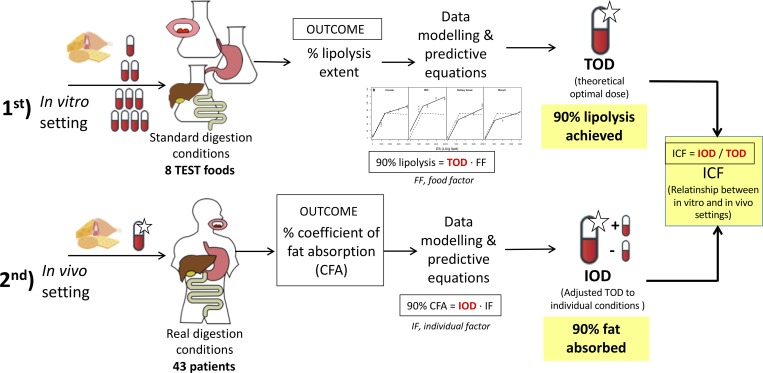
Overview of the combined in vitro and in vivo approach to validate a new evidence-based predictive model to optimally adjust the dose of enzymatic supplements used in PERT, adapted to food and patient characteristics.First a selection of 8 meals were digested in vitro under standard CF conditions, and the % of lipolysis was obtained for the different doses of the enzymatic supplement. Modelling of the % lipolysis extent allowed predicting the theoretical optimal dose for each meal (TOD), which took into account the food characteristics. Second, in the in vivo study the same 8 meals were digested in vivo under real conditions along with their TODs, and the % of fat absorption was measured in all the participating patients. Modelling of the coefficient of fat absorption (CFA) allowed to obtain how different TOD should have been in order to achieve a 90% of CFA (the equivalent outcome to the in vitro setting). In authors’ criterion, the individual correction factor (ICF) allowed for quantifying the relation between the in vitro and the in vivo settings. TOD, theoretical optimal dose; IOD, individual optimal dose; ICF, individual correction factor.